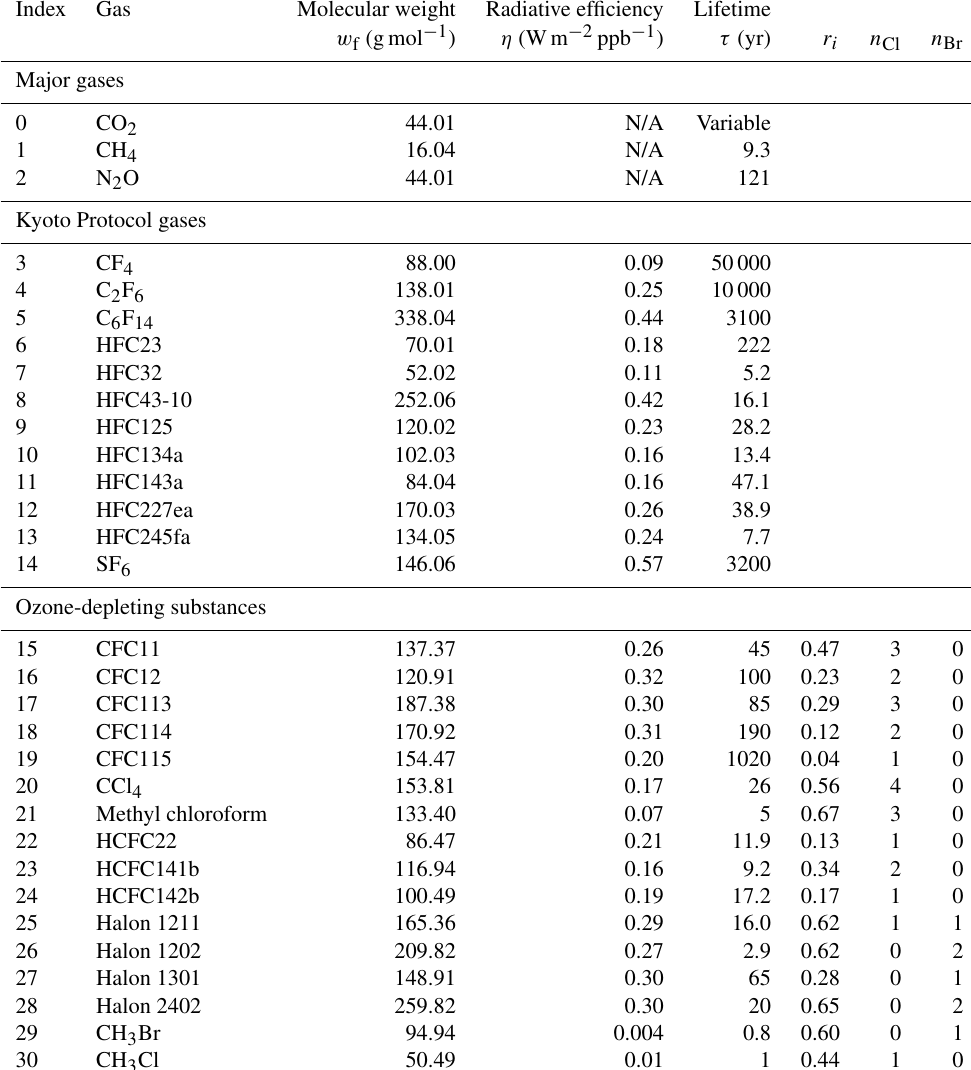
Table 2. The set of greenhouse gases used in FAIR. With the exception of methane lifetime, radiative efficiencies and lifetimes are from AR5 (Myhre et al., 2013b, Table 8.A.1). For ozone-depleting substances, the fractional release coefficients r i (Daniel and Velders, 2011) and the number of chlorine and bromine atoms are also given for the calculation of equivalent effective stratospheric chlorine (Eq. 14). Where ERF is not calculated as a linear function of concentration, “not applicable” (N/A) is